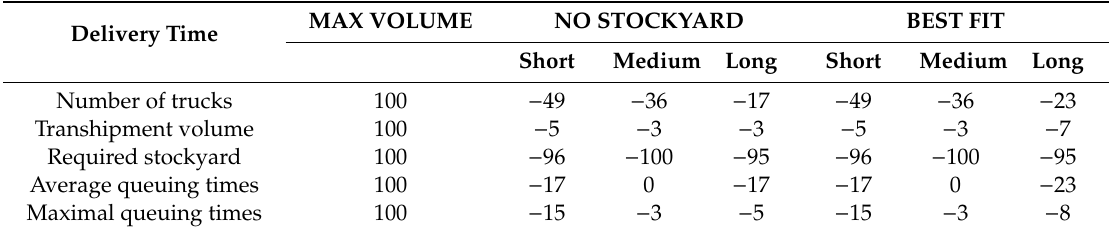
Table 7. Strategy comparison for one train pick-up (in %).